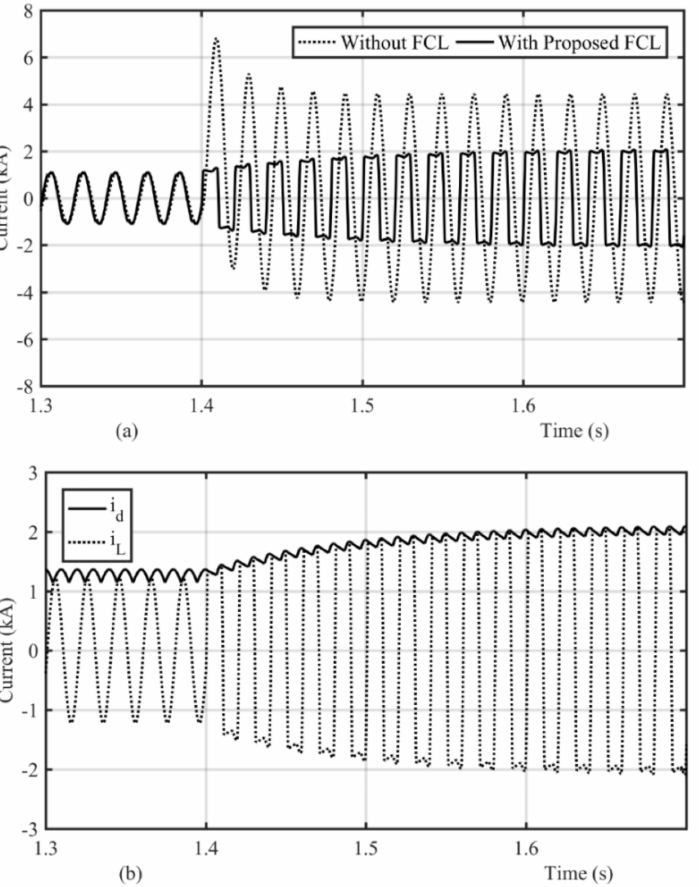
Figure 6. ( a ) Fault current for two scenarios including without FCL and with the CDBFCL, ( b ) non- superconducting DC reactors (NSDR) and fault current in presence of